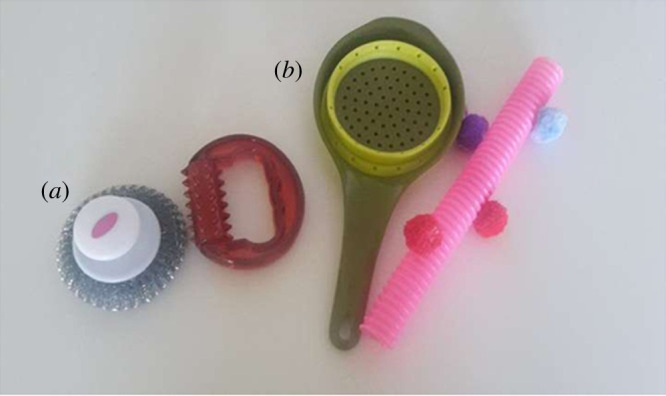
Novel objects used in study 2a ((a): metal scouring pad and massage roller, (b): pink tube with glued felt balls and sieve).